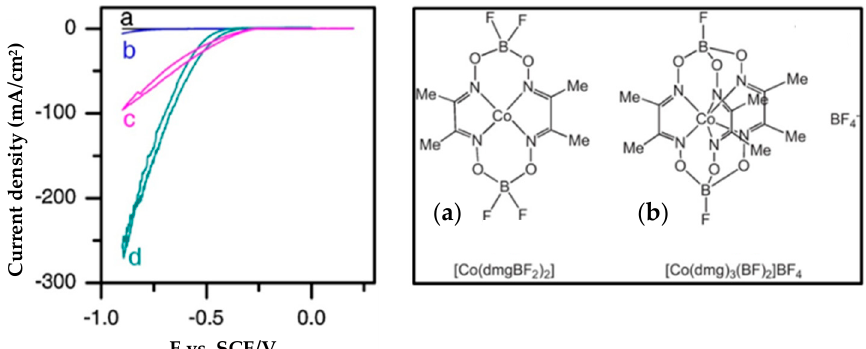
Figure 11. ( left ) Current ‐ potential relations of (a) a clean glassy carbon electrode (GCE), (b) GCE modified with carbon black (Vulcan XC72) and Nafion 117, (c) GCE modified with Vulcan XC72 (70 wt.%), [Co(dmg) 3 (BF) 2 ]BF 4 (30 wt.%) and Nafion 117, (d) GCE modified with Vulcan XC72 (70 wt.%), Co(dmgBF 2 ) 2 (30 wt.%) and Nafion 117, all in a 0.5 M H 2 SO 4 aqueous solution, scan rate: 10 mV/s; ( right ) Molecular structure of the two Co clathrochelates. Reprinted with permission from [165]. Copyright 2012 Elsevier.